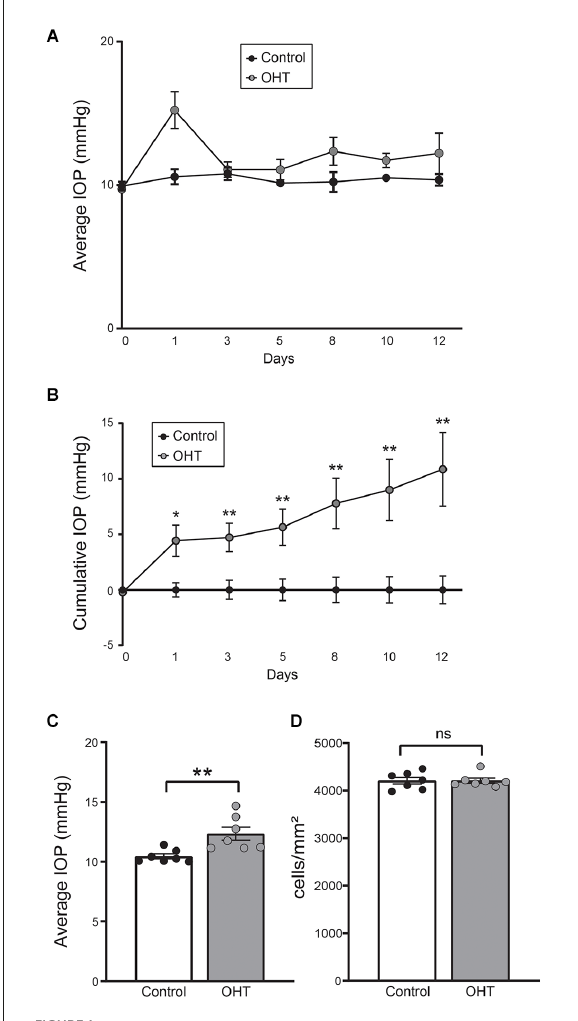
FIGURE1 (A) Average daily intraocular pressure (IOP) over the 2-week long experiment. (B) Cumulative IOP normalized to baseline.